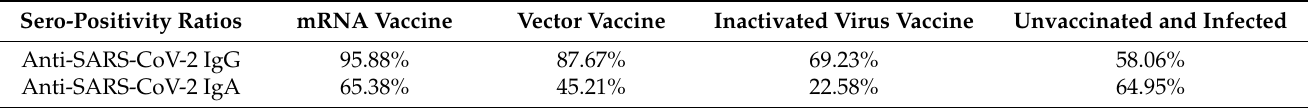
Table 1. IgG and IgA isotype antibody sero-positivity ratios elicited by different vaccines. Sero-Positivity Ratios mRNA Vaccine Vector